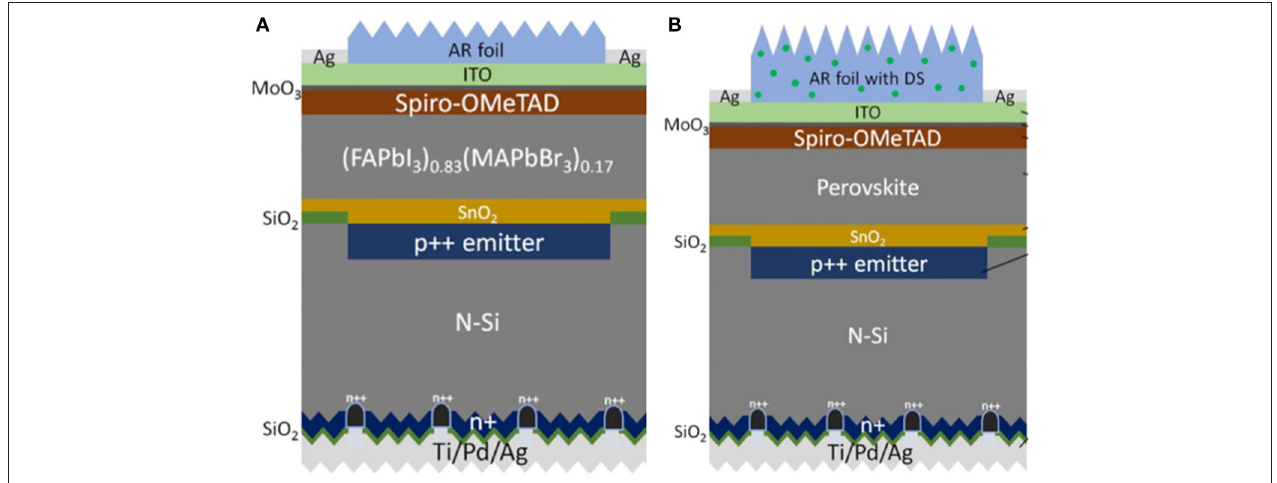
FIGURE 11 | Schematic of PVSK/Si-homojunction solar (A) (reproduced from ref. 78, copyright 2018, The Royal Society of Chemistry) and (B) (reproduced from ref. 79, copyright 2018, ACS).